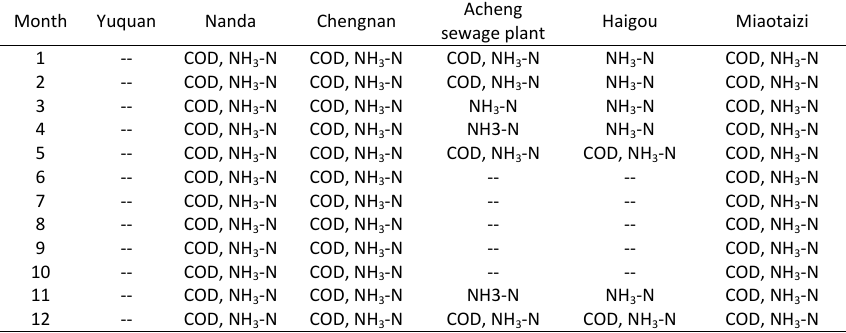
Table 8: Dynamic control strategy of water pollution at Acheng District Section in Ashi River